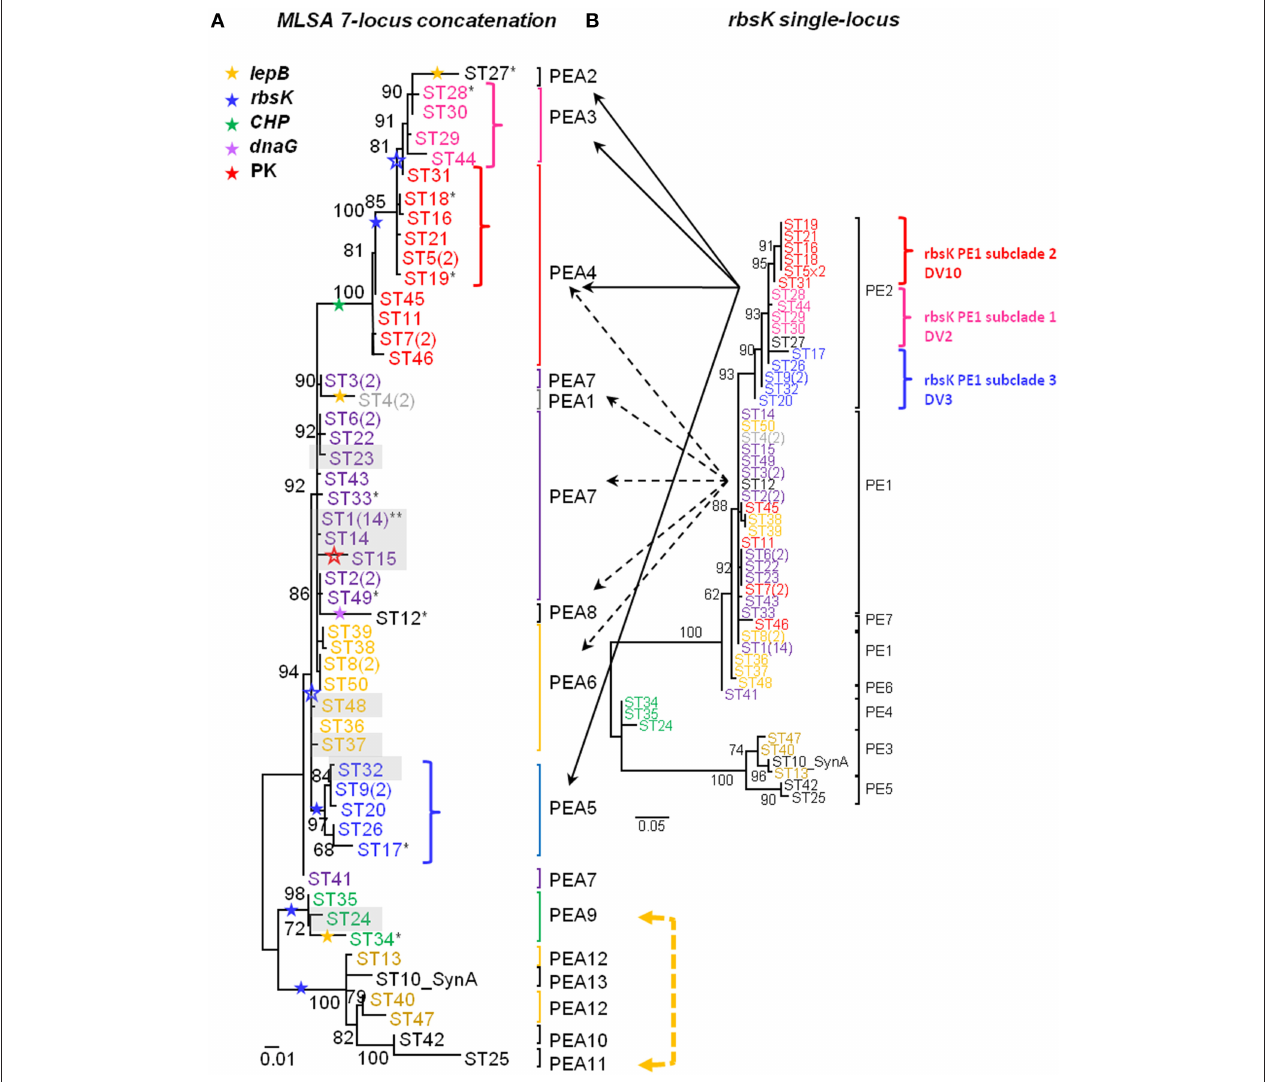
FIGURE 2 | A-like Synechococcus phylogenies based on maximum likelihood analysis of (A) 7 concatenated BAC loci and (B) BAC-associated rbsK sequences. Putative ecotypes (PEs) demarcated by Ecotype Simulation are indicated by brackets or vertical bars adjacent to each tree. STs within PEs are colored according to the MLSA phylogeny shown in A and colors are maintained in both phylogenies (color correspondence also maintained in Supplemental Data Presentation Figure 14). The number of variants belonging to dominant and subdominant sequence types (STs) is indicated in parentheses. Stars, colored coded according to gene (see inset star legend), demarcate recombination events interpreted from SNP patterns confirmed (closed stars) or not confirmed (open stars) by Clonal Frame analysis. Clade splitting events between rbsK and the concatenated phylogeny, where grouped variants within rbsK are split apart into separate PEs in the concatenated phylogeny, are indicated by dashed (clade splitting event of rbsK PE1) and solid arrows (clade splitting event of rbsK PE2). Non-syntenous STs are shaded in gray and STs that contained a combination of sequences that were syntenous and non-syntenous are indicated by an asterisk; syntenous STs are not shaded and are not annotated by an asterisk. Shared SNP pattern between STs of two distinct PEs indicated by a bidirectional arrow colored according to gene (yellow = lepB ). Bootstrap values are provided for major nodes. Reference genome indicated by “SynA”; Genbank accession number CP000239.